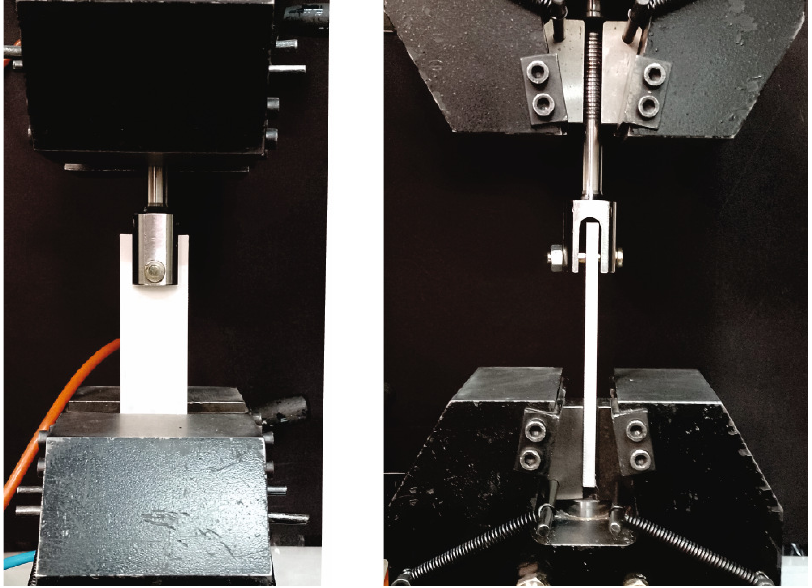
Figure 3. A 3D-printed specimen under test conditions, front view ( left ) and side view ( right ).